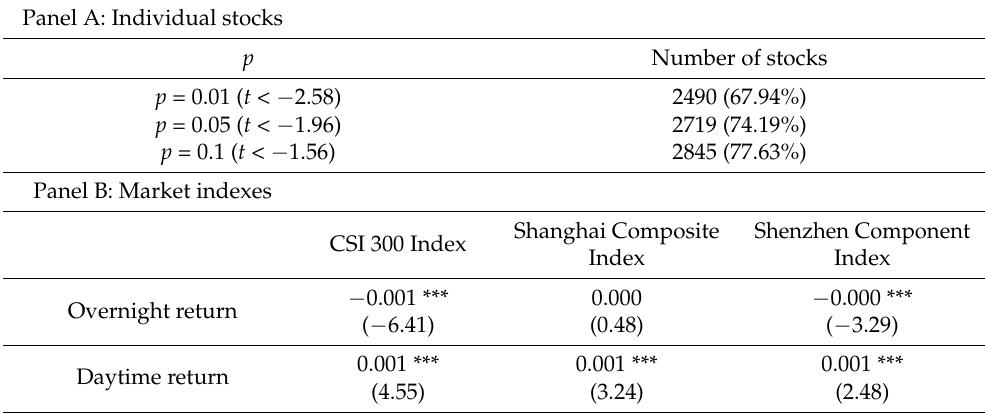
Table 1. Tests for the overnight return anomaly. Panel A shows the results for individual stocks. “ p ” indicates the significance level and “Number of stocks” indicates the number of stocks with negative return at each significance level. Panel B shows the results for the representative market